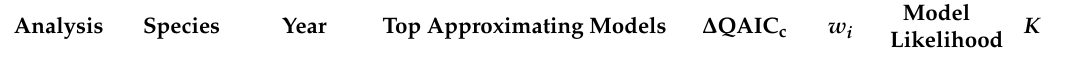
Table 5. Summary statistics for supported ( ∆ QAIC c < 7) candidate models and top competing ( ∆ QAICc < 2) models used to describe (top model or ∆ QAIC < 2 in model averaging) 2011 and 2012 Epioblasma c capsaeformis, Actinonaias pectorosa , and Medionidus conradicus data in Program MARK.